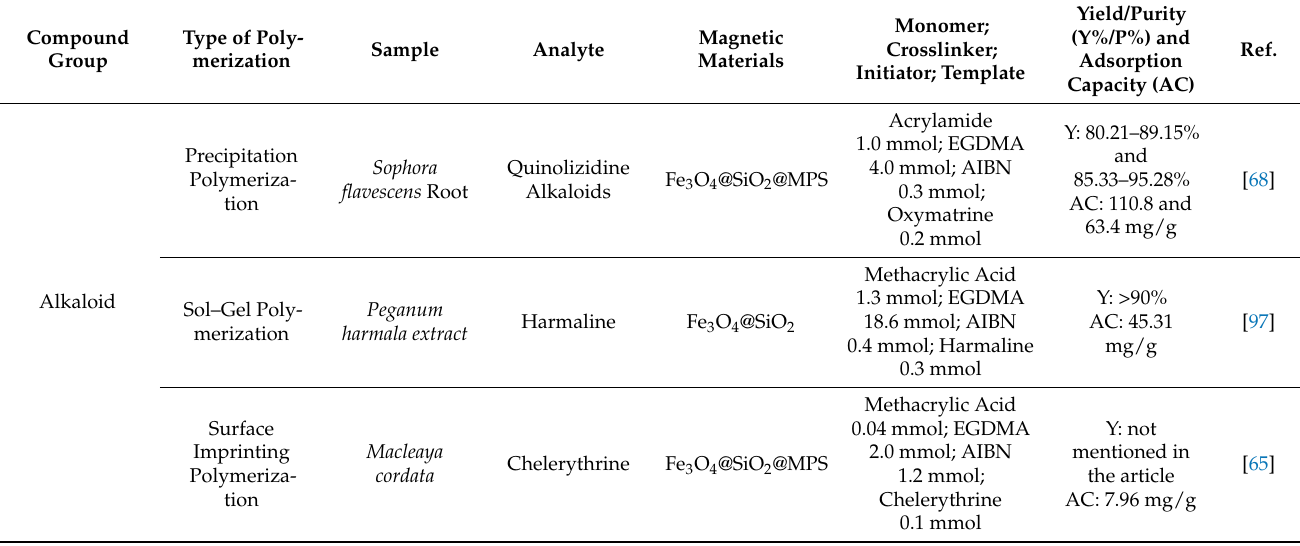
Table 4. Application of MMIPs in natural